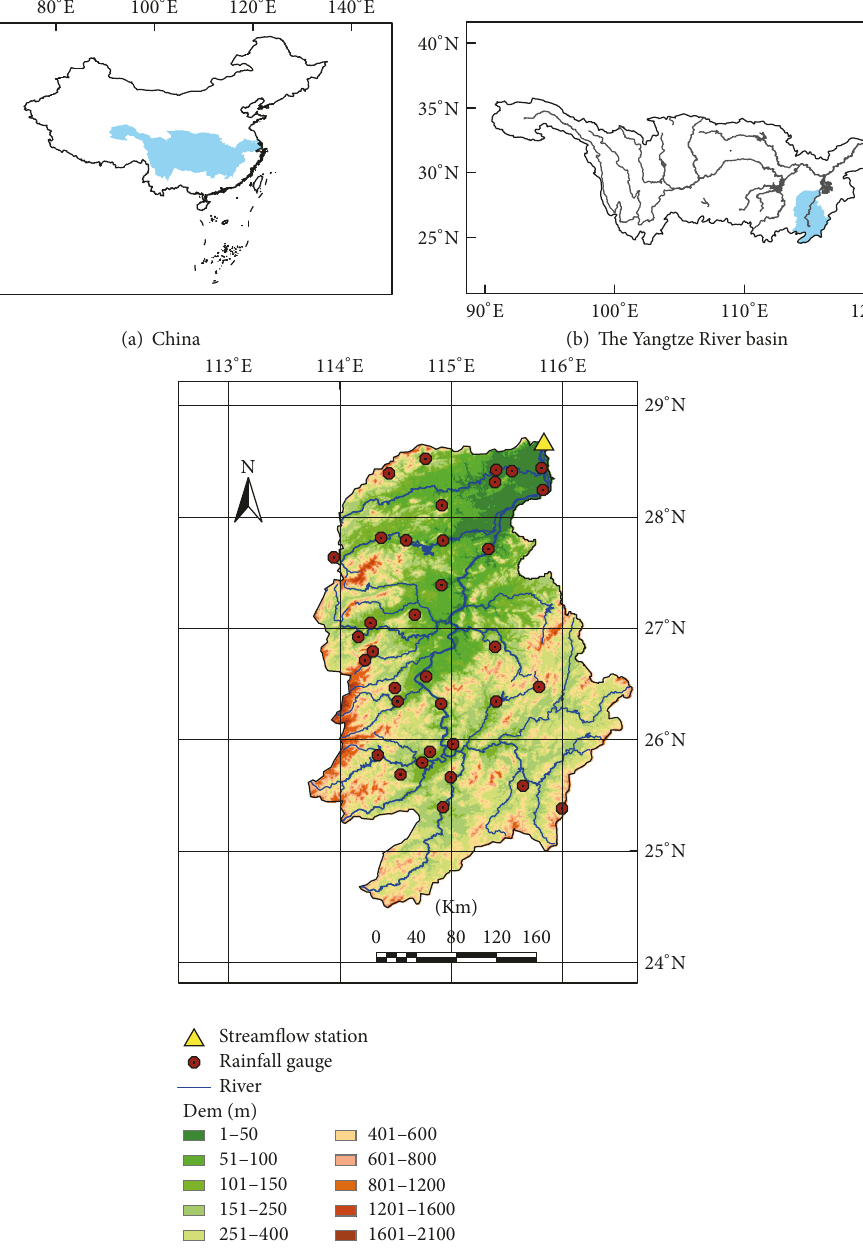
Figure 1: Location of Ganjiang River basin and gauge